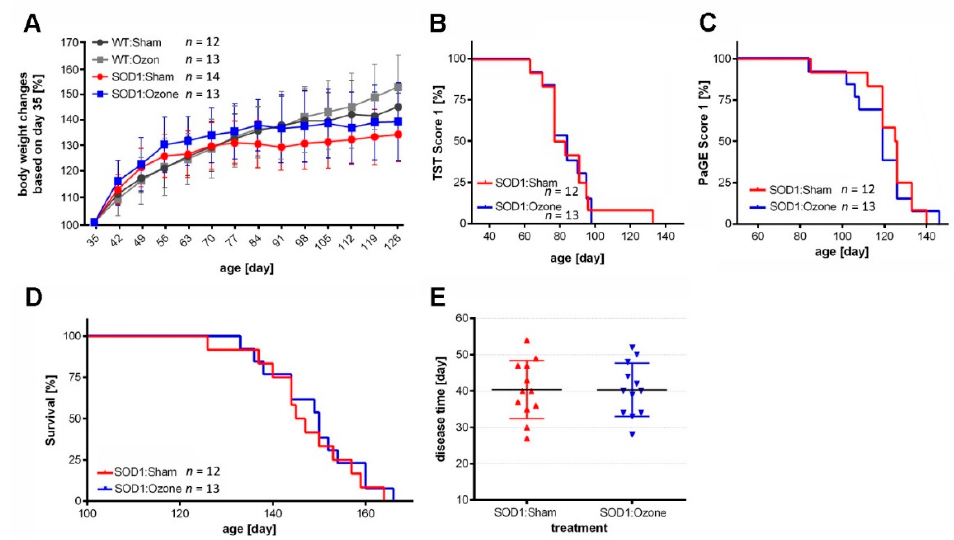
Figure 1. Clinical assessment of the study mice. ( A ) Changes in body weight normalized to 100% at P35. Values represent mean ± S.D. p = n.s. between groups, two-way ANOVA with Tukey correction. ( B ) Tail suspension test (TST) evaluating the beginning of motor deficits in the hind limbs (score = 1), p = 0.968, n.s., Log-Rank test. ( C ) Paw grip endurance test (PaGE) evaluating motor strength and endurance (score = 1), p = 0.672, n.s., Log-Rank test. ( D ) Survival analysis, p = 0.565, n.s., Log-Rank test. ( E ) Scatter plot (mean ± S.D.) of disease duration in days from first day of treatment to end-stage in sham- or ozone-treated SOD1 G93A mice. p = 0.979, n.s., unpaired t -test.